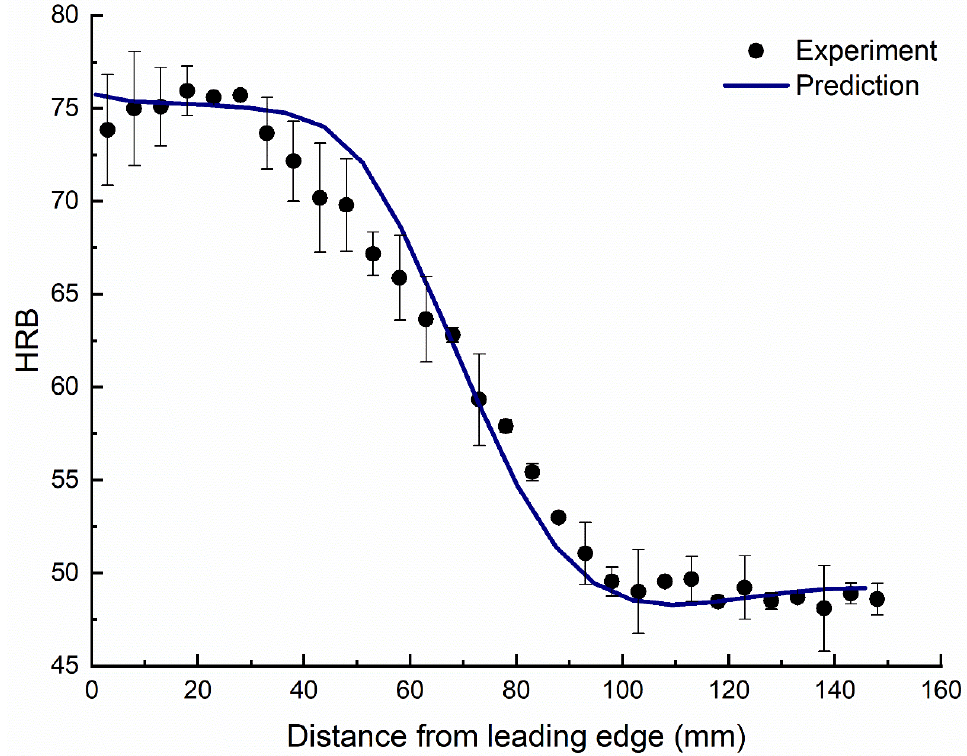
Figure 7. The experimental and predicted hardness vs. distance from the leading-edge (in y-direction).